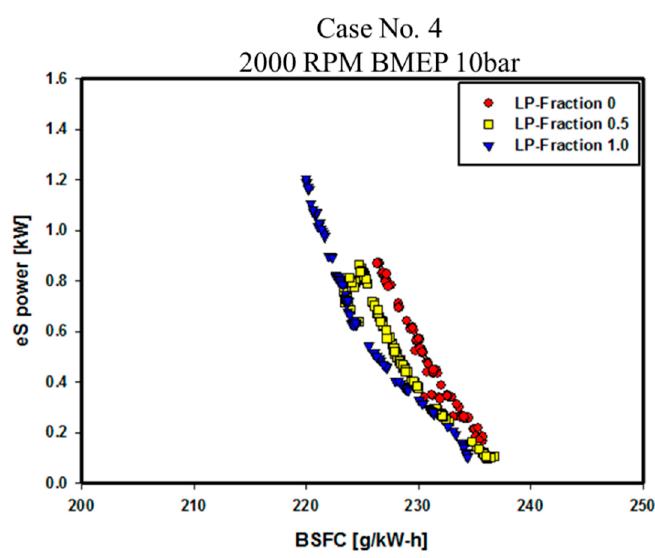
Figure 18 . eS power difference for various LP fractions on the Pareto front line of case 4.